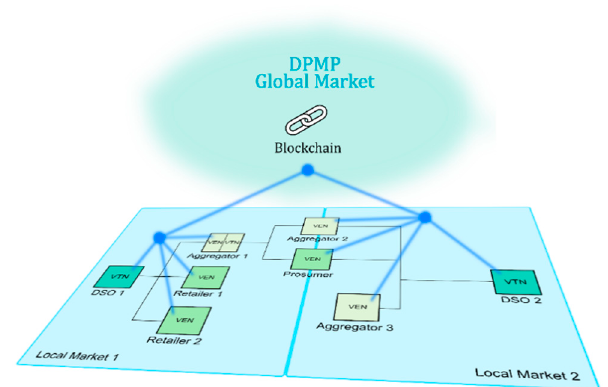
Figure 7. Decentralized Permissioned Market Place (DPMP) and Local Markets integration schema.